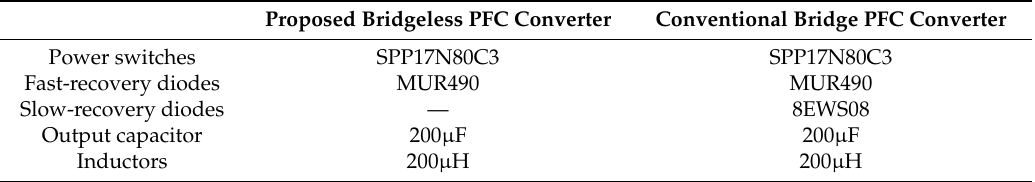
Table 2. The selected components